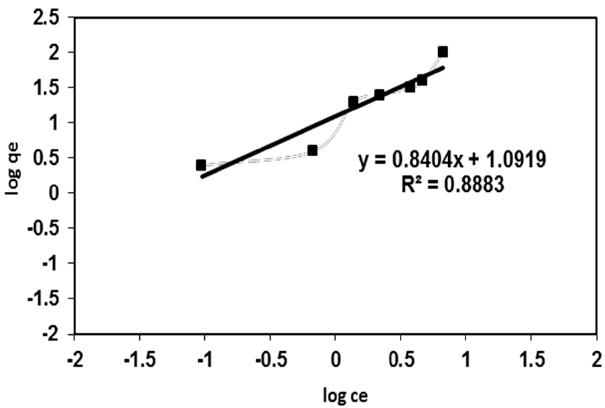
Figure 6. Freundlich adsorption isotherm for BV 14 dye adsorption onto the chemically modified nanofibers.